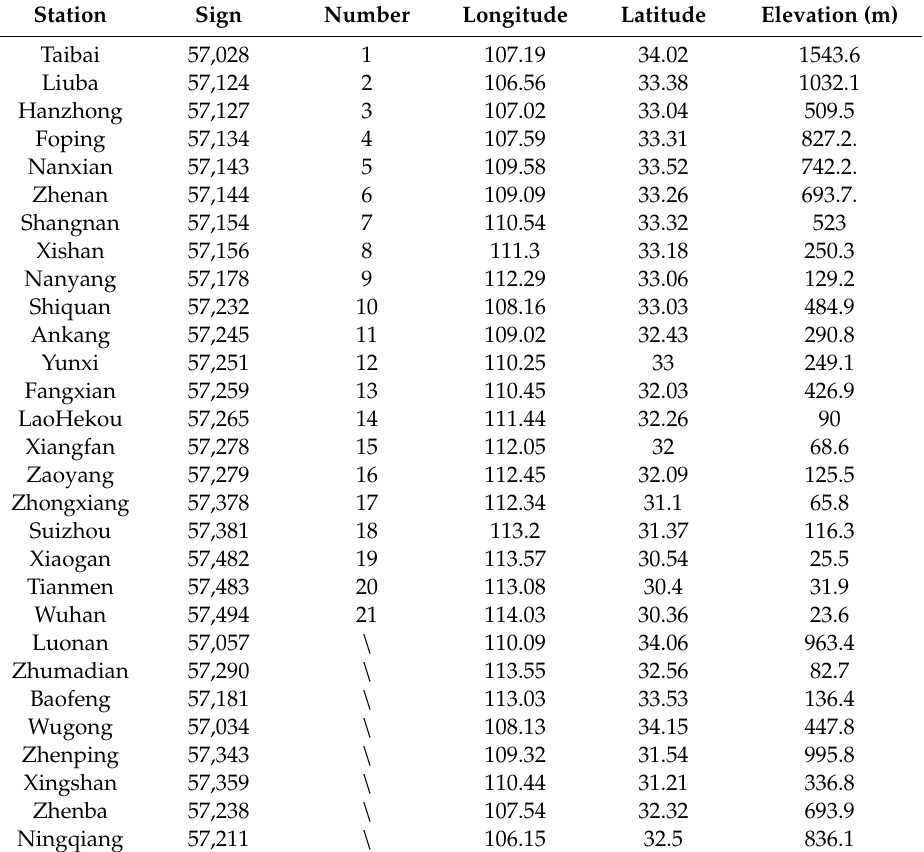
Table 1. Location information of meteorological